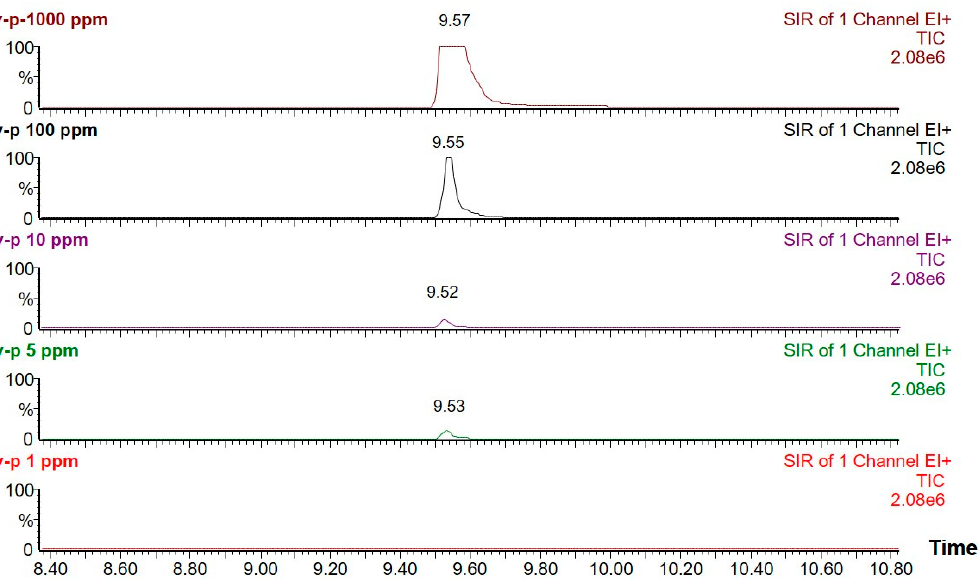
Figure 6. The chromatograms (TIC) of calibration standard (1000 ppm, 100 ppm, 10 ppm, 5 ppm, 1 ppm) using optimized GC-MS conditions.